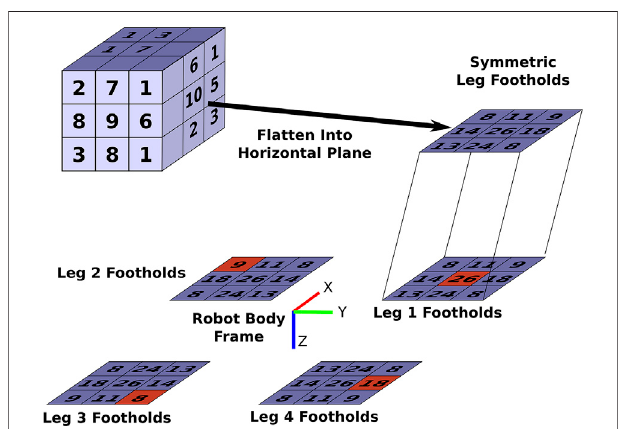
FIGURE6| Illustration ofthe calculation ofthe approximation of average static stability criteria metric . The highlighted red squares indicate an example sampling of the possible footholds of the quadruped from its four